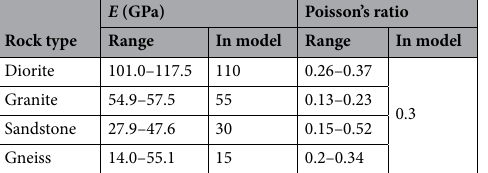
Table 2. Basic material properties of four rocks and input parameters in the